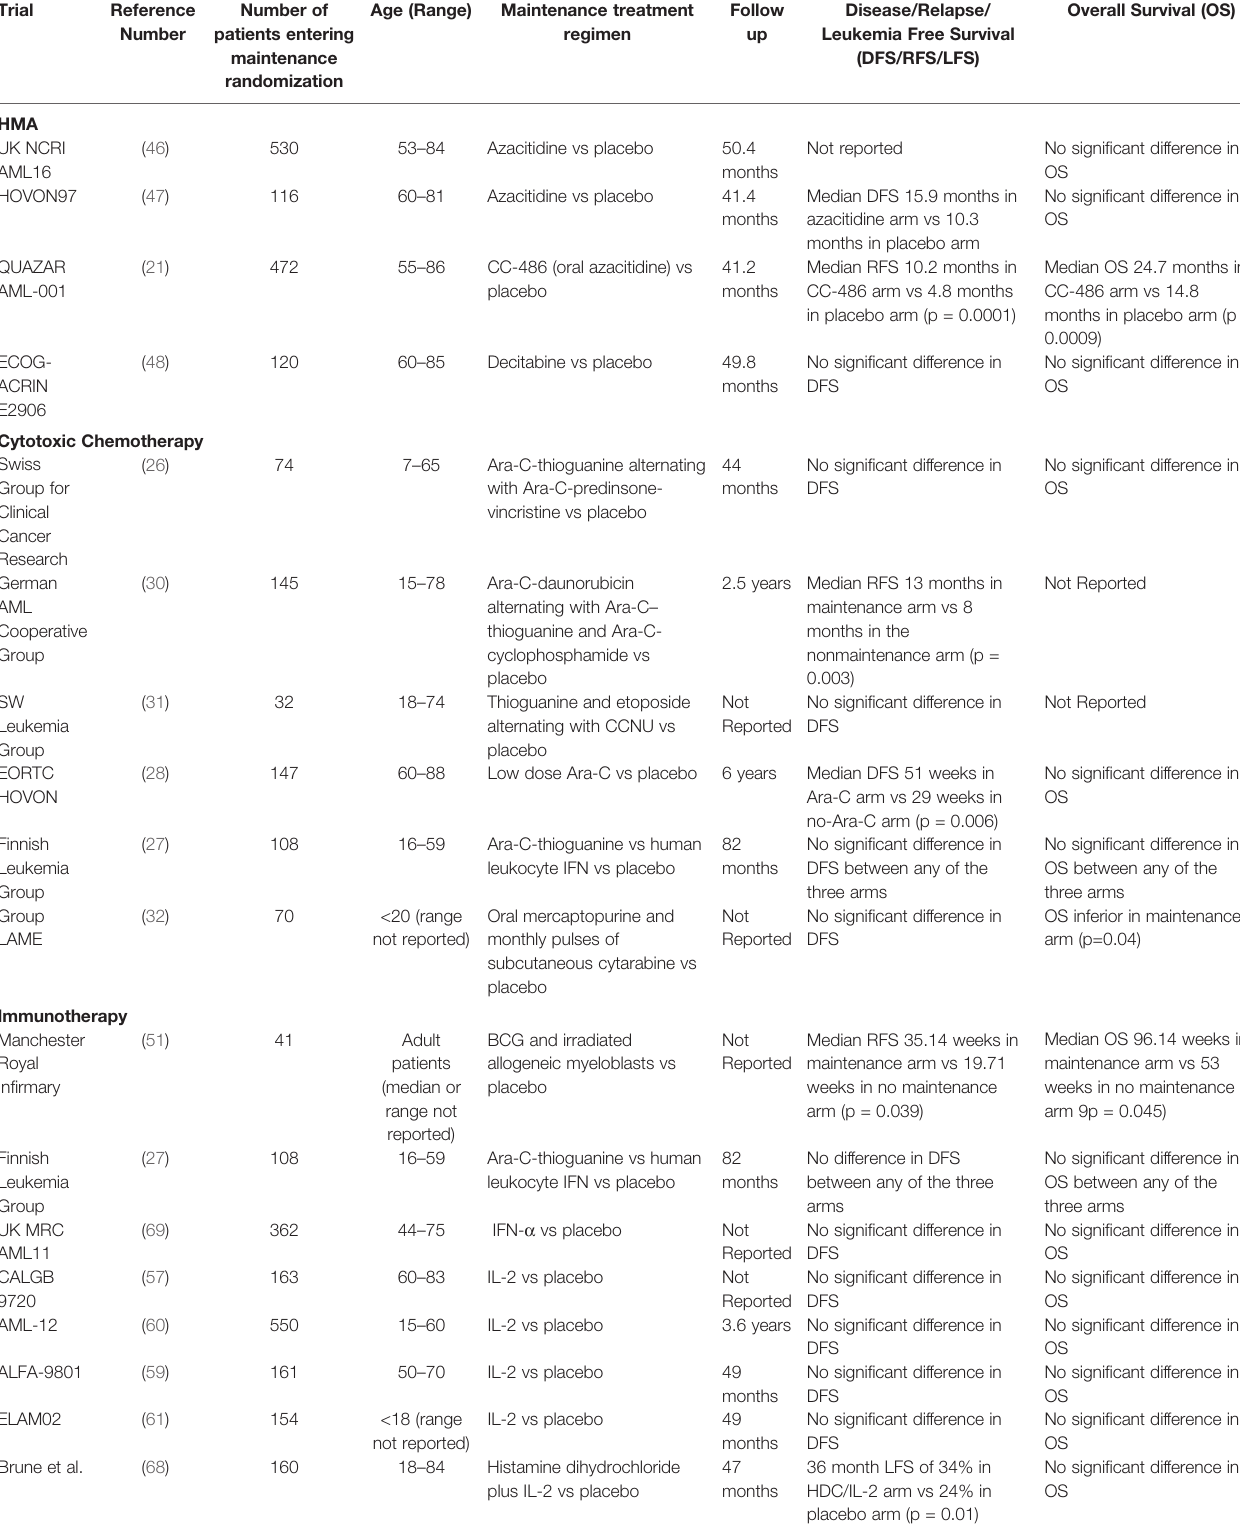
TABLE 1 | Summary of placebo controlled, randomized studies of maintenance therapy in